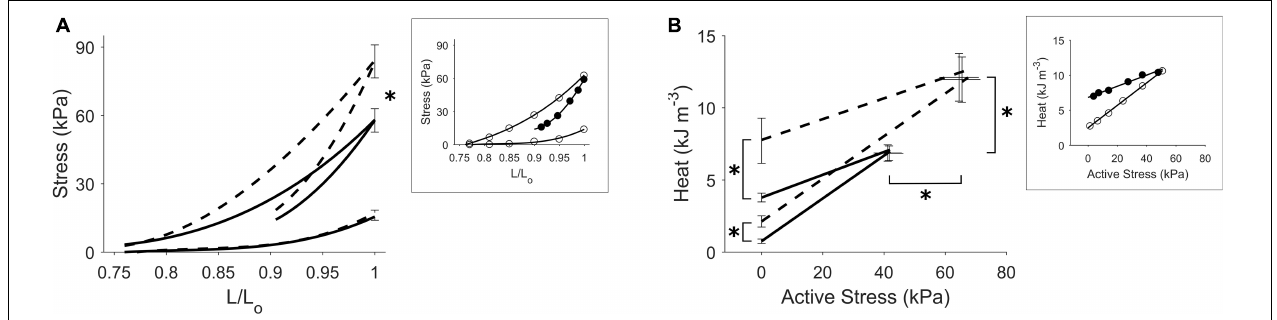
FIGURE 5 | Effects of increased contractility. Average regression lines from trabeculae in the Control group (continuous lines) and those in the Isoproterenol group (broken lines) undergoing preloaded isometric contractions and afterloaded work-loop contractions at L o are shown in each panel. The asterisk in panel (A) indicates a statistically significant difference between the regression lines. The asterisks in panel (B) signify effects of isoproterenol on the heat-intercepts as well as on the peak active stress and muscle heat output. Standard errors of means at peak values are superimposed in all panels. The insets depict regression lines fitted to the data from a representative Control trabecula where open circles denote isometric contractions and filled circles denote work-loop contractions at L o